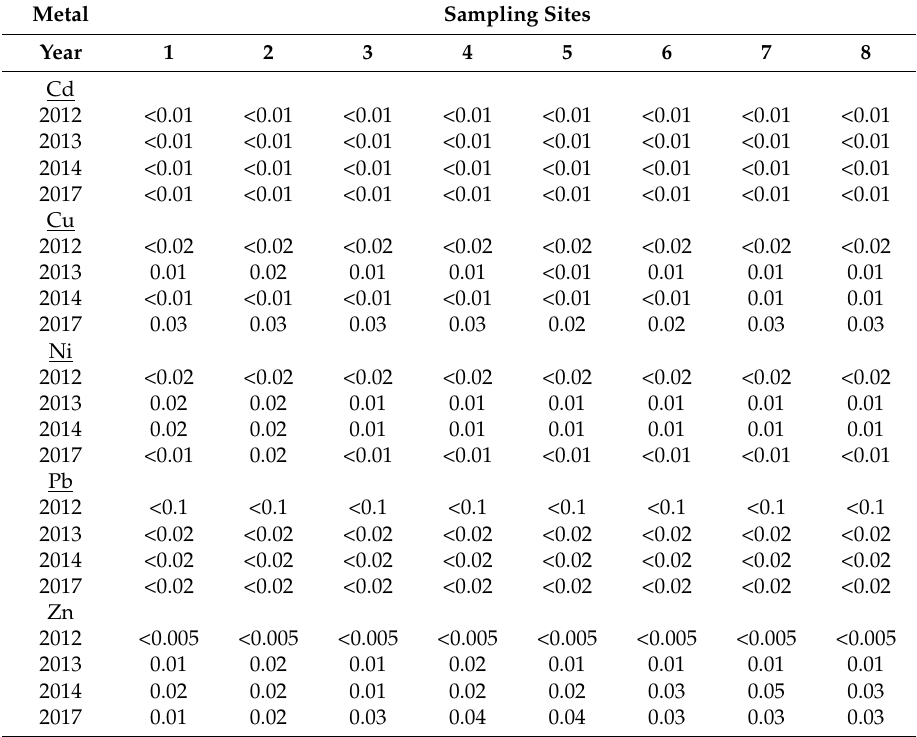
Table 4. Heavy metal content in water (mg/L) before the flood (2012, data from Tikhonova et. al, 2012 [11]), during the flood (2013, data from Sirotkin et al, 2013 [9]), and after the flood (2014 and 2017, original data). The < sign indicates values bellow the limit of